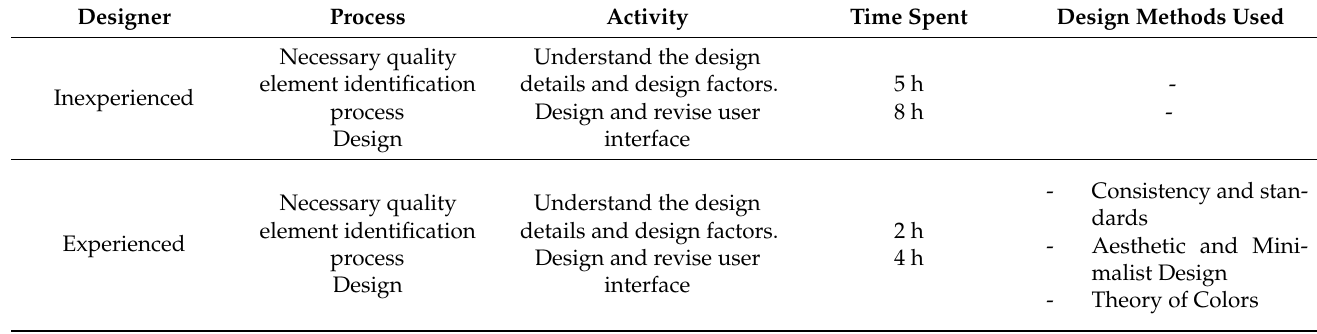
Table 11. Time taken to complete redesign activities when PIN framework was